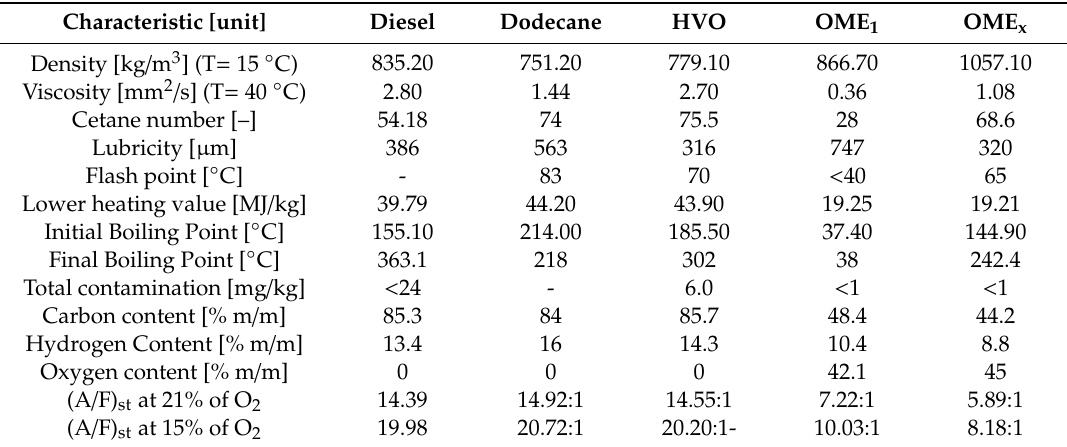
Table 1. Fuel properties.